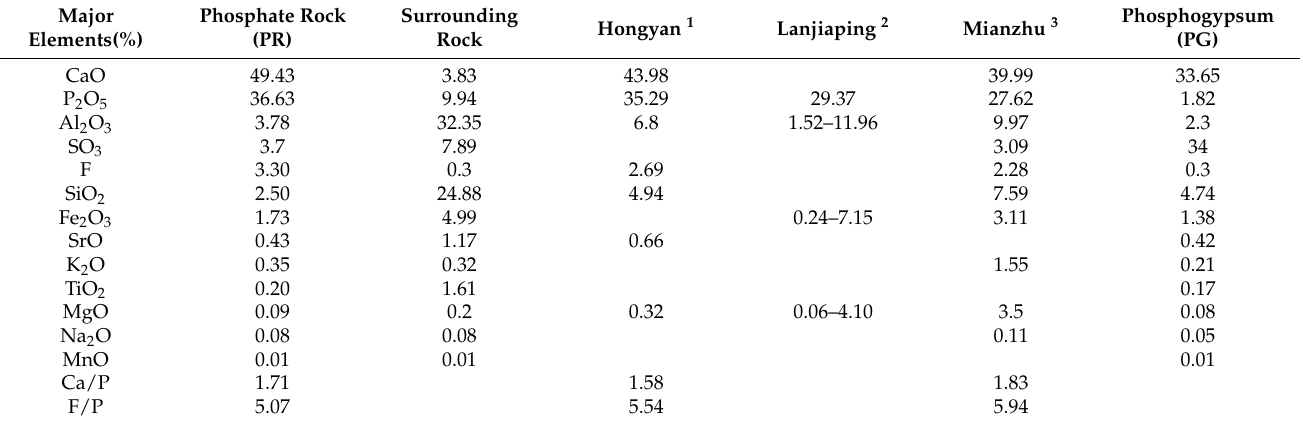
Table 1. Major element analysis in phosphate rock (PR) and phosphogypsum (PG). Major Phosphate Rock Surrounding Hongyan 1 Lanjiaping 2 Mianzhu 3 Elements(%) (PR) Rock